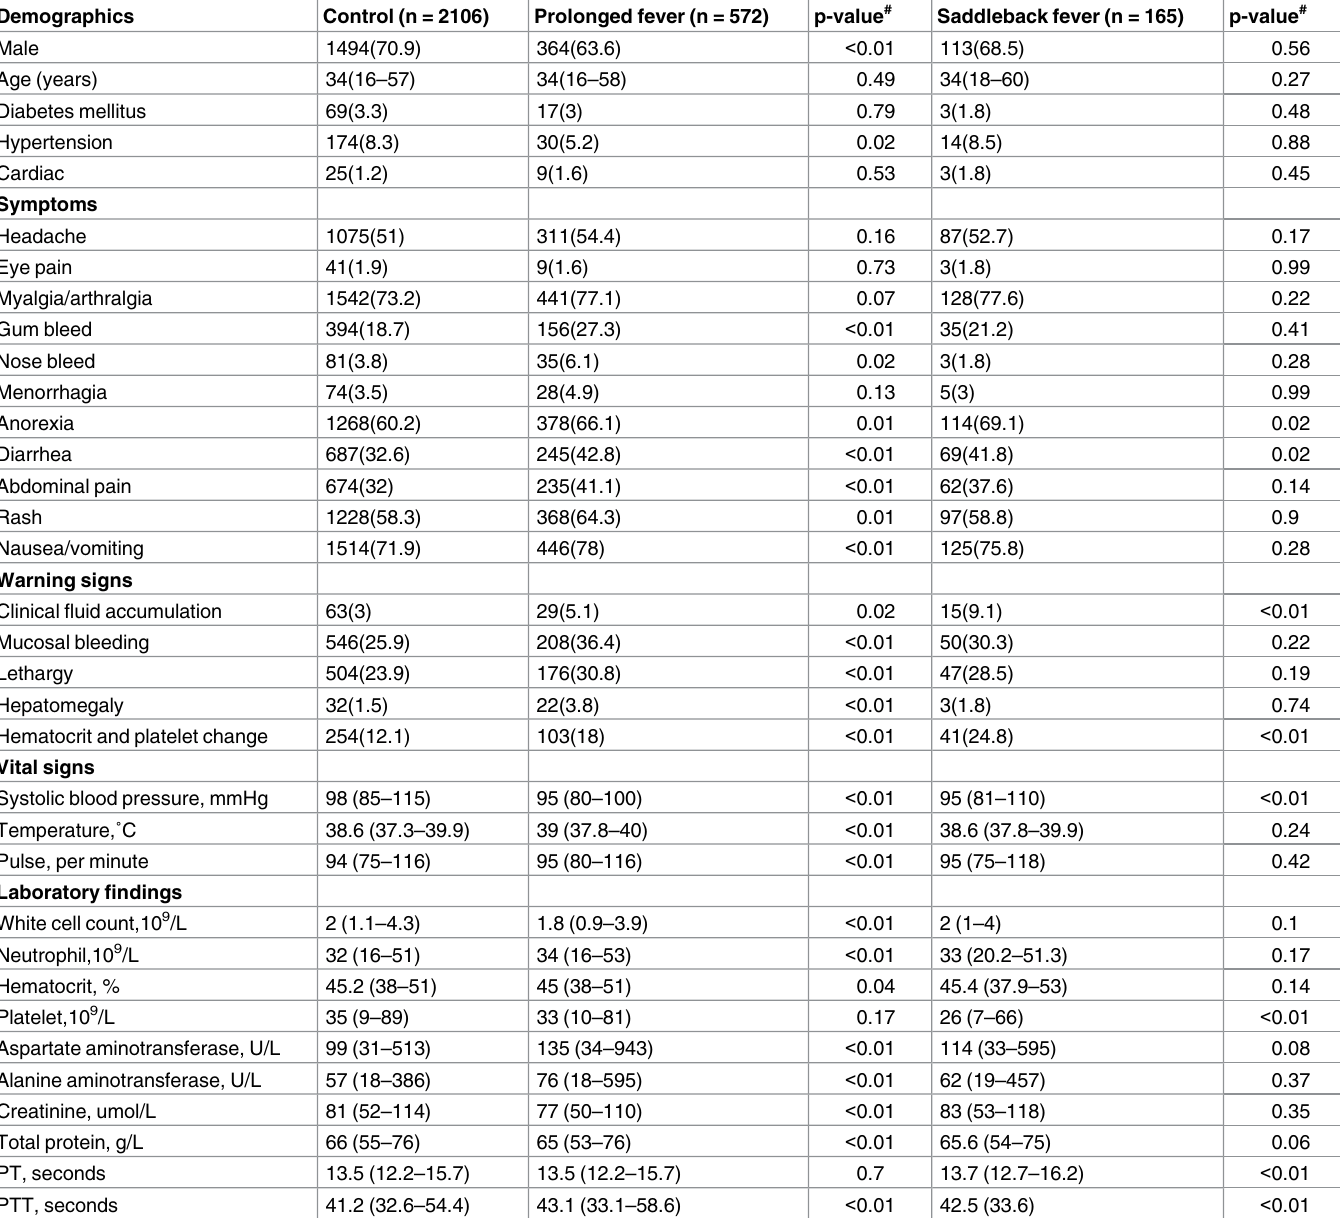
Table 1. Demographic, clinical and laboratory features of prolonged and saddleback fever in adult